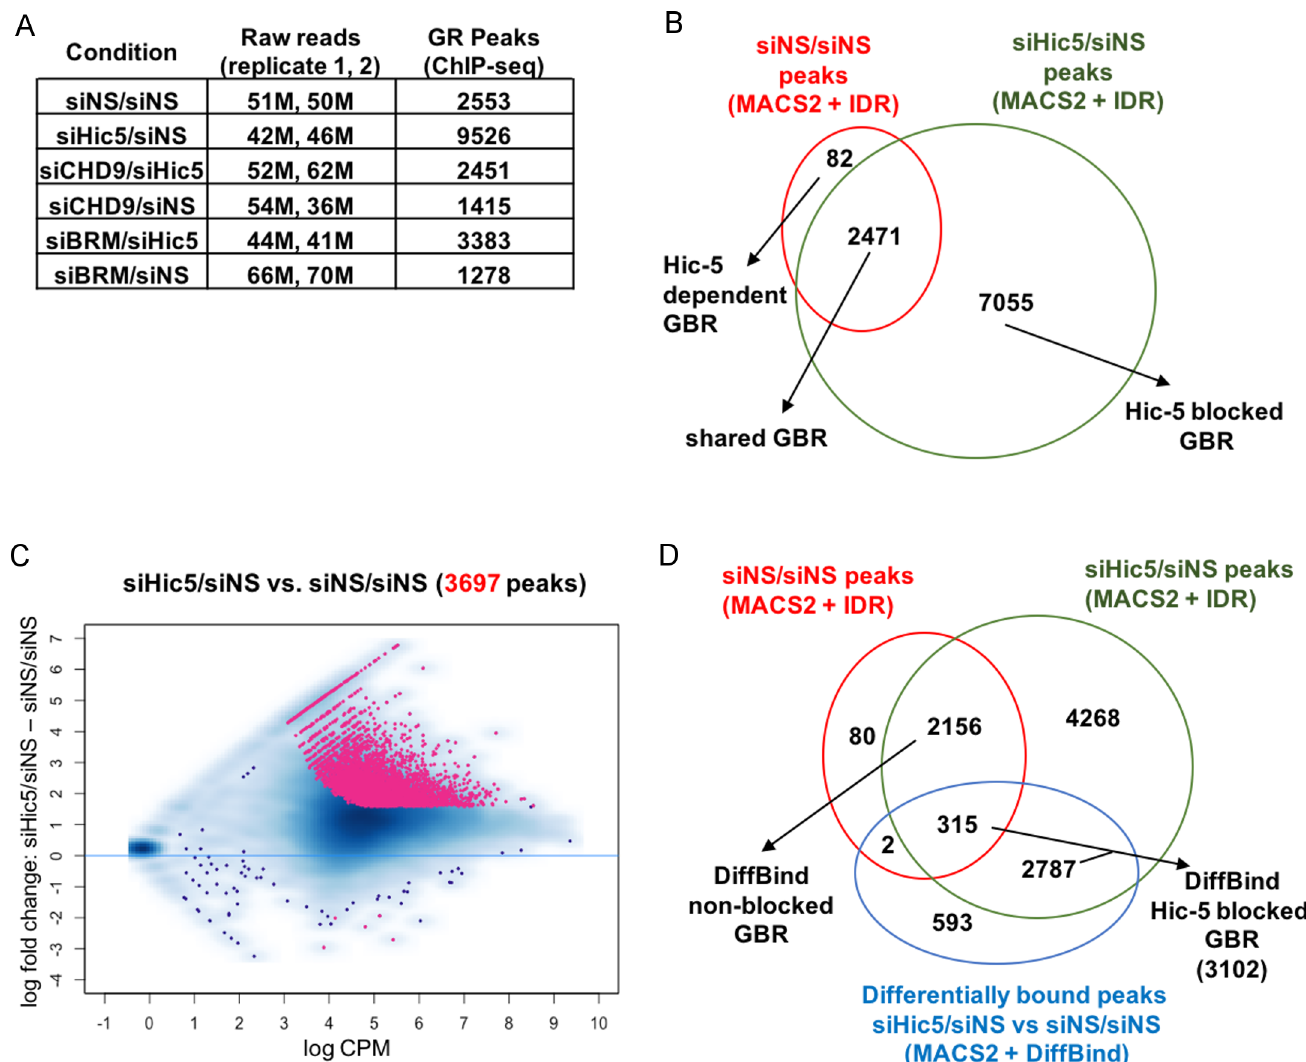
Fig 1. Identifying Hic-5 blocked GBR and non-blocked GBR. (A) Total GR peaks (or GR binding regions, GBR) identified for each condition using the MACS2 +IDR method. ChIP-seq with GR antibody was performed on U2OS-GR α cells transfected with indicated siRNA combinations and treated with dex for 1 hr. Total raw reads for the duplicate samples are also shown. (B) Venn diagram showing overlap of GR peaks after 1 hr dex treatment in Hic-5 positive cells (siNS/siNS) and Hic-5 depleted cells (siHic5/siNS). (C) MA plot analysis to identify GBR with statistically altered level of GR binding between Hic-5 positive cells (siNS/siNS) and Hic-5 depleted cells (siHic5/siNS). X-axis shows the log 2 of the average GR binding intensity for each GBR (in counts per million, cpm) from all conditions as mentioned in A. Y-axis shows the log 2 fold-change in GR binding between siHic5/siNS and siNS/siNS for each GBR. Each red dot represents a GR peak that is significantly different between siHic5/siNS and siNS/siNS with FDR < 0.01 and at least a 3-fold change in binding. Blue dots represent peaks not differentially bound between siNS/siNS and siHic5/siNS with blue smears indicating overrepresentation of blue dots. (D) Identification of Hic-5 blocked and non-blocked GBR by statistical analysis of differential GR binding. Three-way Venn diagram overlapping GBR in Hic-5 positive and Hic-5 depleted cells identified by MACS2+IDR method with GBR having significantly different GR binding between these two conditions as defined by MACS2+DiffBind method. DiffBind Hic-5 blocked GR peaks are GBR found only in Hic-5 depleted cells using the MACS2+IDR method that have a significant difference in GR binding intensity between Hic-5 depleted cells and Hic-5 positive cells using the MACS2+DiffBind method. DiffBind non-blocked GBR are GR binding sites found in both Hic-5 positive and Hic-5 depleted cells using the MACS2+IDR method but have no significant difference in binding intensity between Hic-5 depleted cells and Hic-5 positive cells as defined by the MACS2+DiffBind method. that Hic-5 blocks GR binding to specific loci on a genome-wide basis (Fig 1A). When these 2 sets of GBR were overlapped, almost all of the GR peaks detected in cells containing Hic-5 were also detected in cells depleted of Hic-5 (2471 shared GBR), but there were 7055 Hic-5 blocked GBR that were called only after depletion of Hic-5 (Fig 1B).